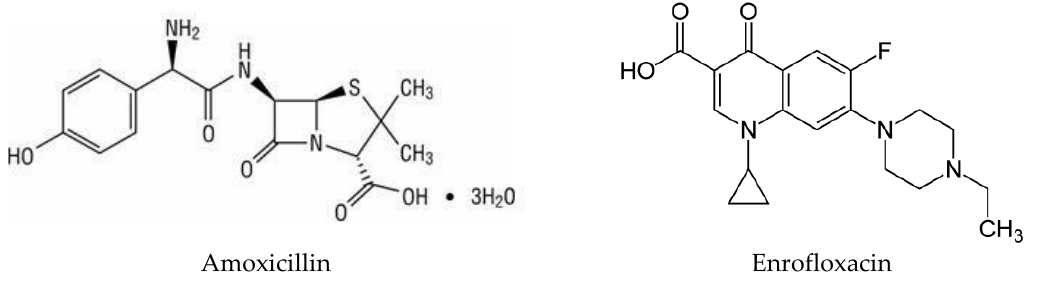
Figure 1. Chemical structure of amoxicillin and enrofloxacin.